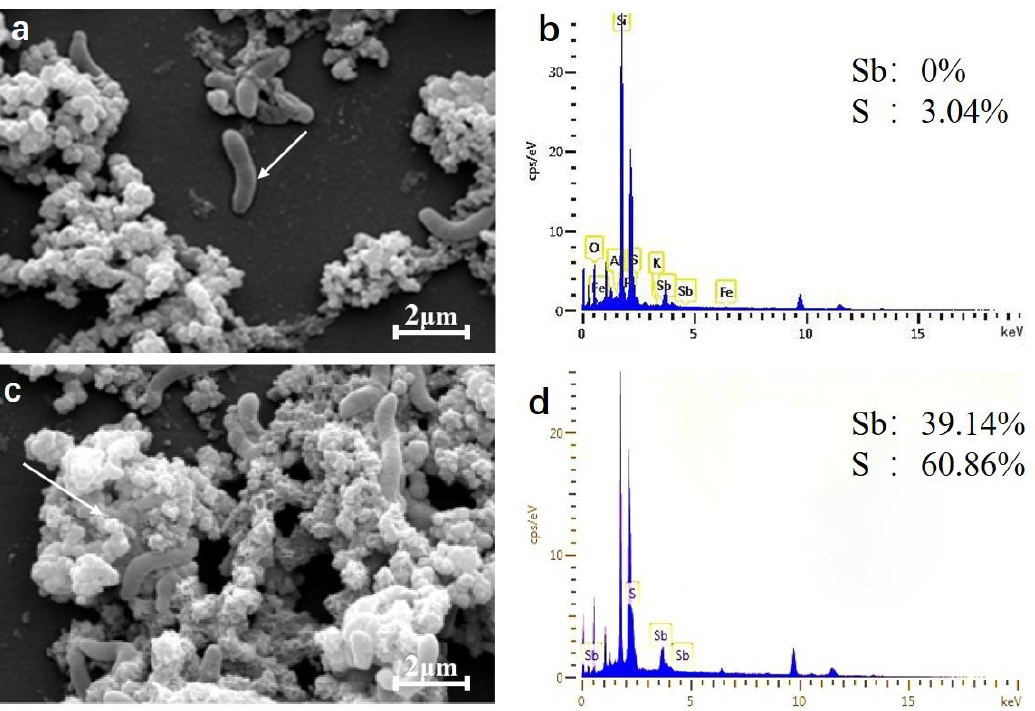
Figure 6. Scanning electron micrographs of cells ( a ) and mineral precipitates ( c ) and EDX spectrum on the cell surface ( b ) and mineral precipitates ( d ) shown by white arrows.